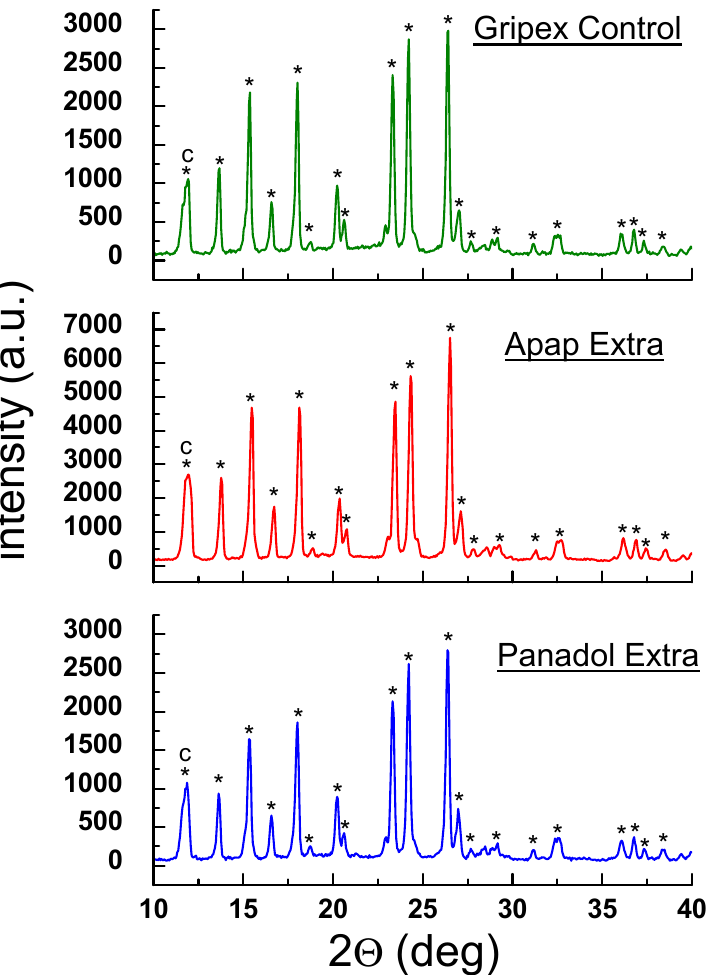
Figure 5. Diffraction patterns for drugs: Gripex Control, Apap Extra, and Panadol Extra. (* -acetaminophen, c – caffeine)